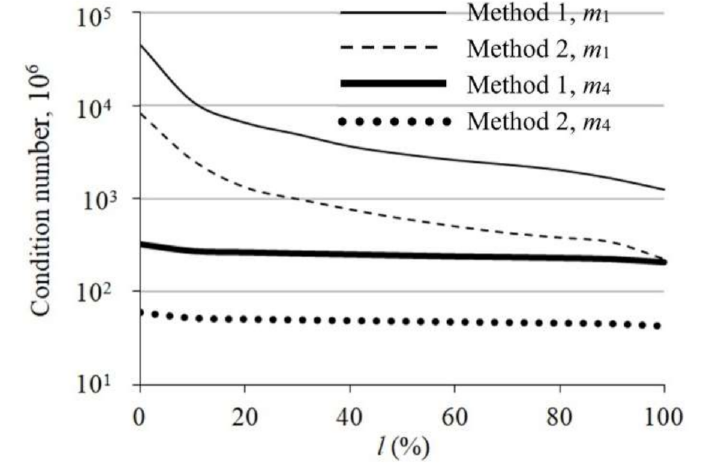
Figure 10. The condition number in the state-estimation process for load level V 1.5 .